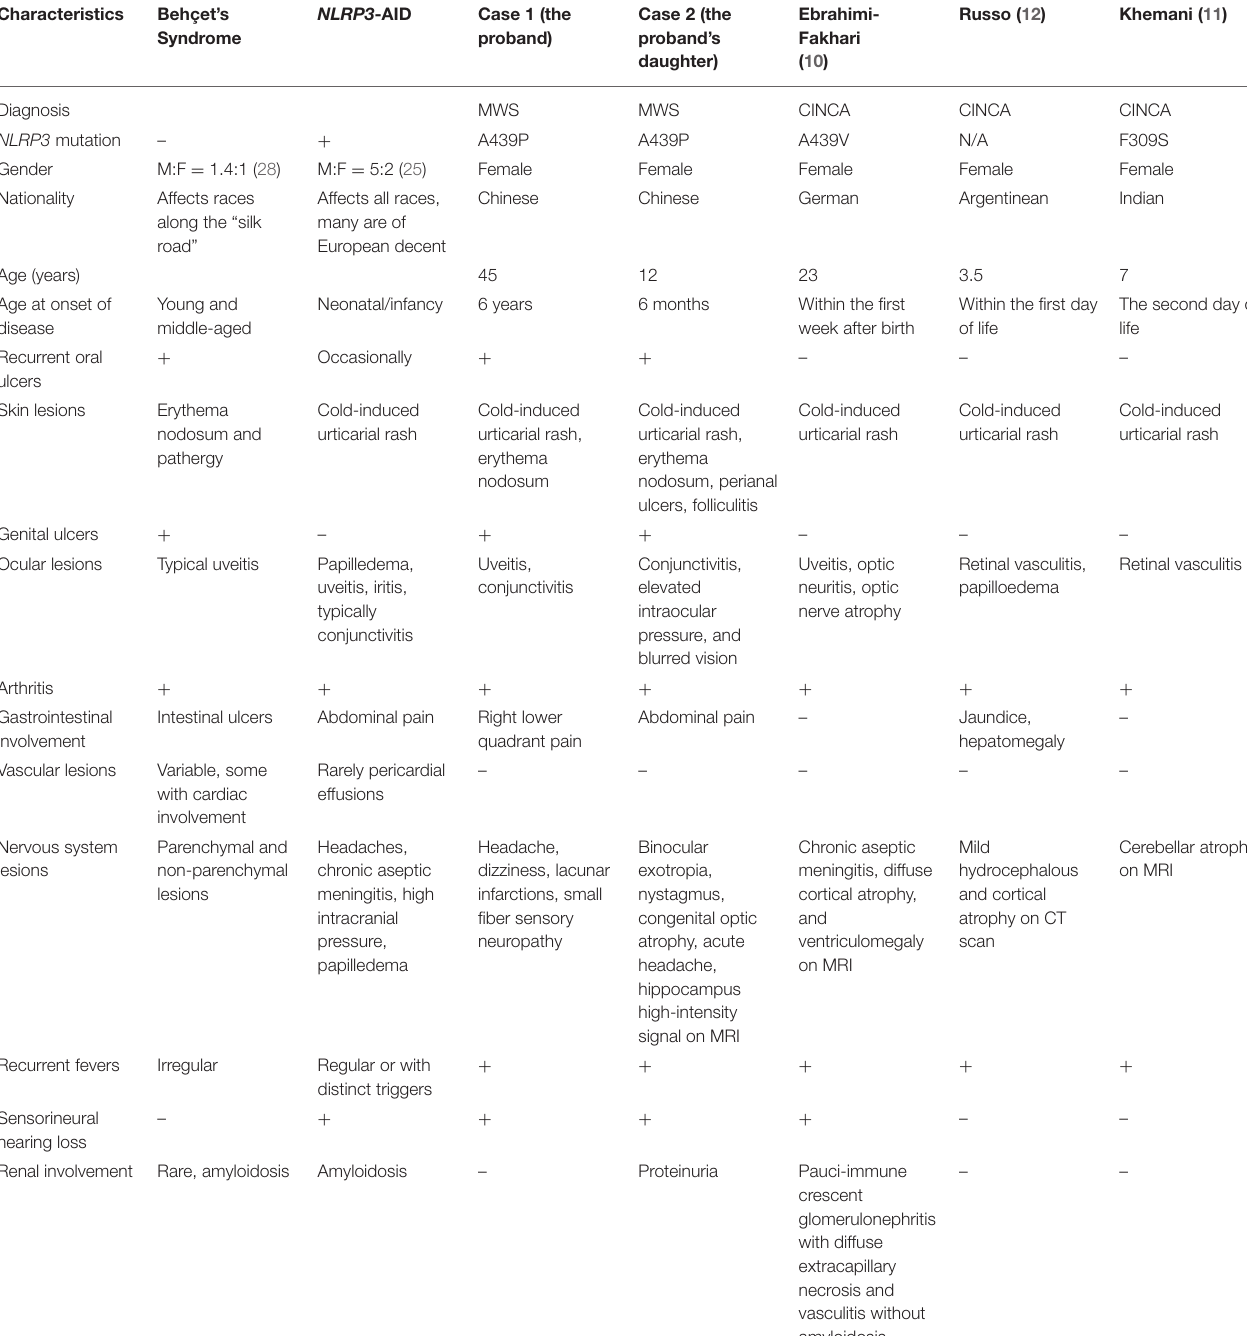
TABLE 1 | Vasculitis associated with NLRP3 -AID and comparison of NLRP3 -AID with Behçet’s syndrome. Characteristics